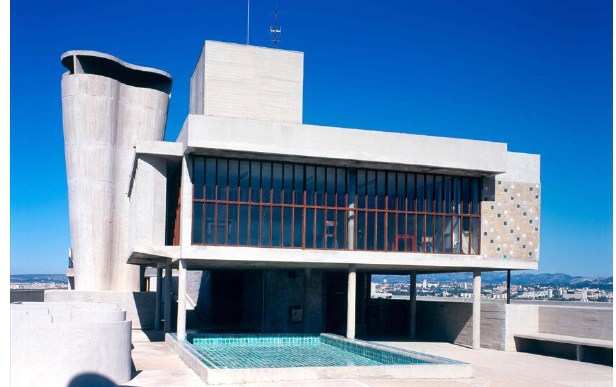
Figure 16. Kindergarten on roof in Unité